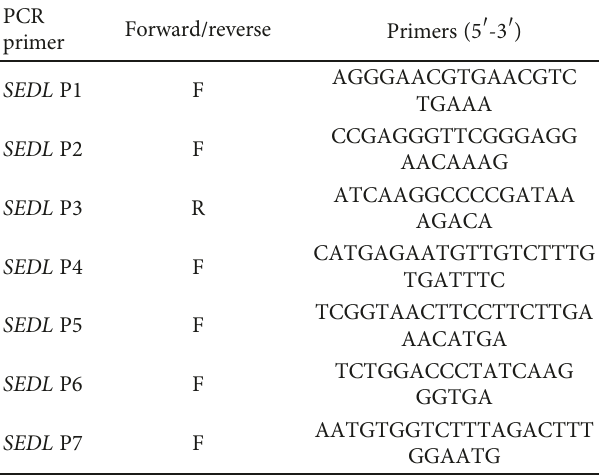
Table 2: Sequences of sequencing